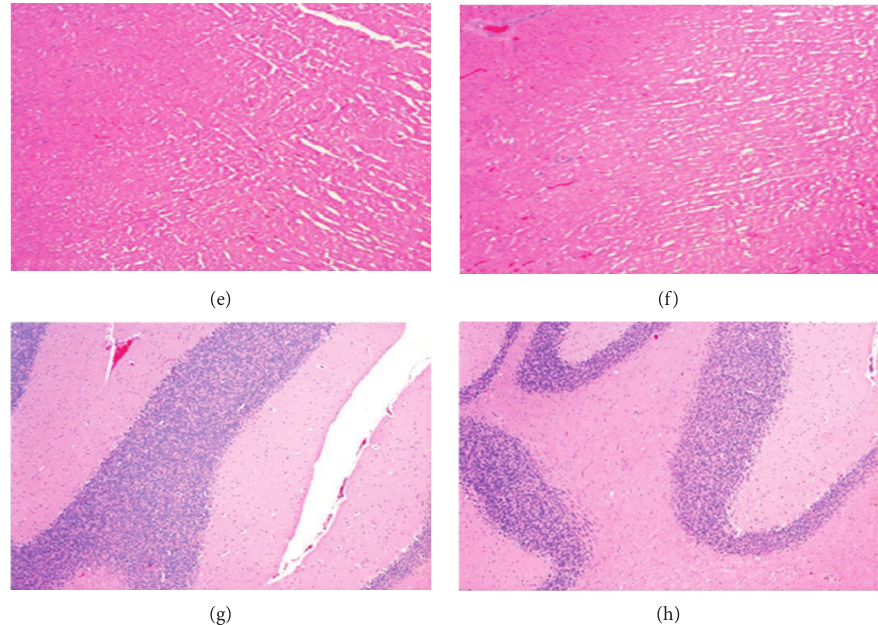
Figure 1: Photomicrographs showing representative hematoxylin-eosin-stained (100x) sections of the liver, kidney, heart, and brain of the control and 1000mg/kg GMCT-supplemented rats in the 28-day toxicity study. The left panels (a), (c), (e), and (g) present the liver, kidney, heart, and brain of the control rats, respectively. The right panels (b), (d), (f), and (h) present the liver, kidney, heart, and brain of the GMCT- 1000-supplemented rats, respectively. There are no treatment-related microscopic changes in the major tissues of GMCT-supplemented rats compared to the control